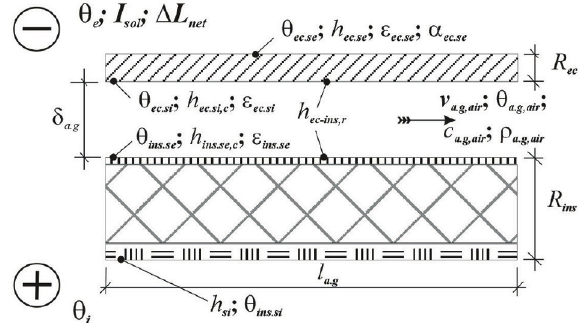
Fig. 1. Principal scheme of the ventilated envelope and heat flow rates describing heat exchange processes in the envelope